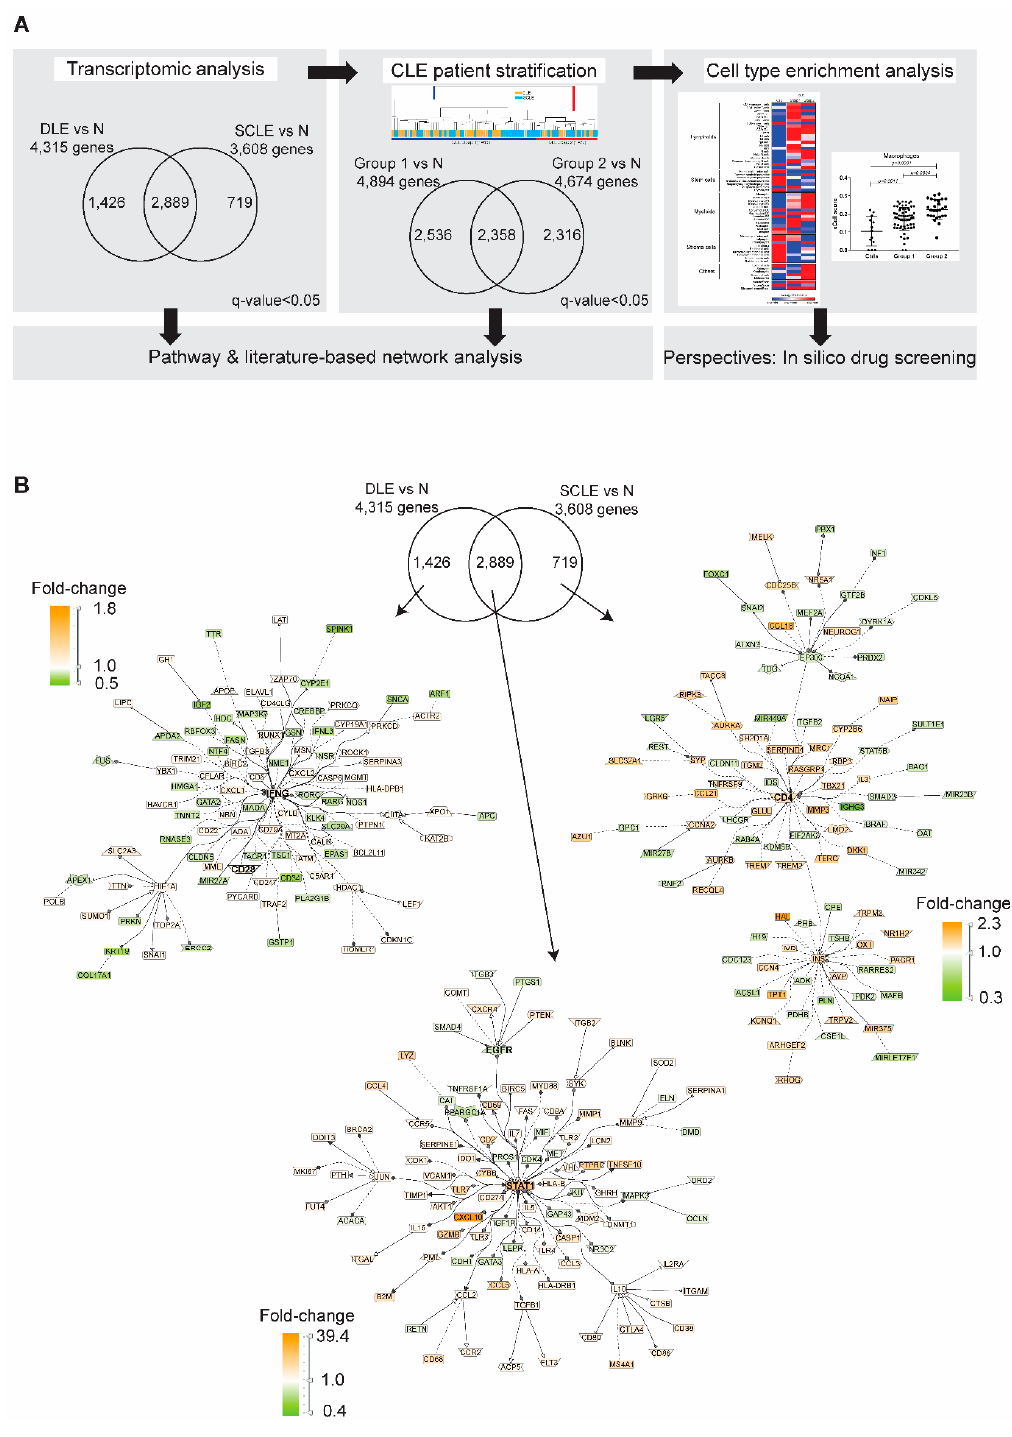
Figure 1. Transcriptomic comparison of DLE and SCLE lesions. ( A ). Graphical representation of the strategy used to analyze CLE lesions at a transcriptional level. ( B ). Literature-based networks (GePS) obtained from the genes regulated in DLE and SCLE vs. normal biopsies. The pictures display the 100 best connected genes co-cited in PubMed abstracts in the same sentence linked to a function word (most relevant genes/interactions). Orange represents the genes that are upregulated and green represents the genes that are downregulated in skin lesions compared to controls.